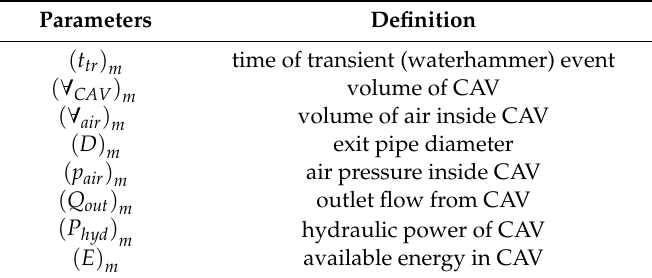
Table 2. Major parameters for operation of CAV in TI-CAES